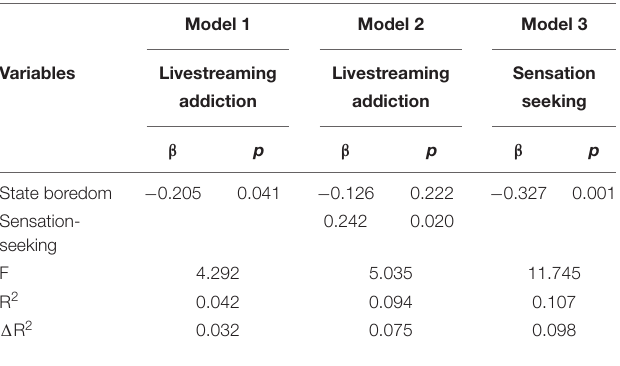
TABLE 6 | Mediating effects of sensation seeking by regression